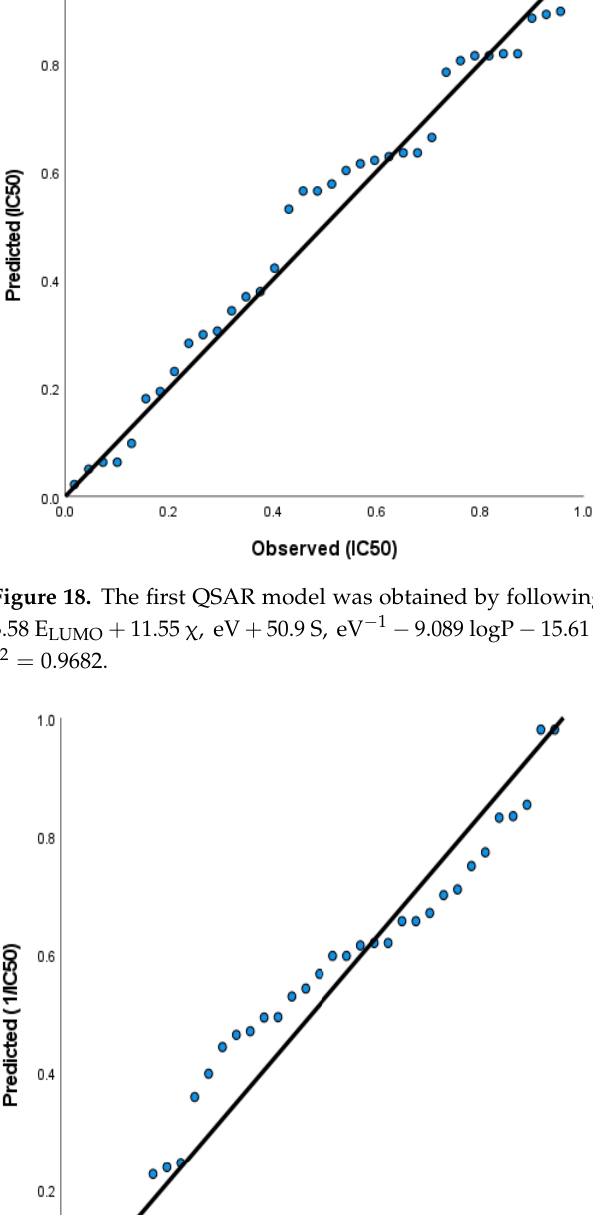
Figure 19. The second QSAR model was obtained by following regression equation 1 −1 − 5.48 HBD . (HCT) = 18.64 − 6.00 E g , eV − 0.289 η + 64.6 S, eV IC50